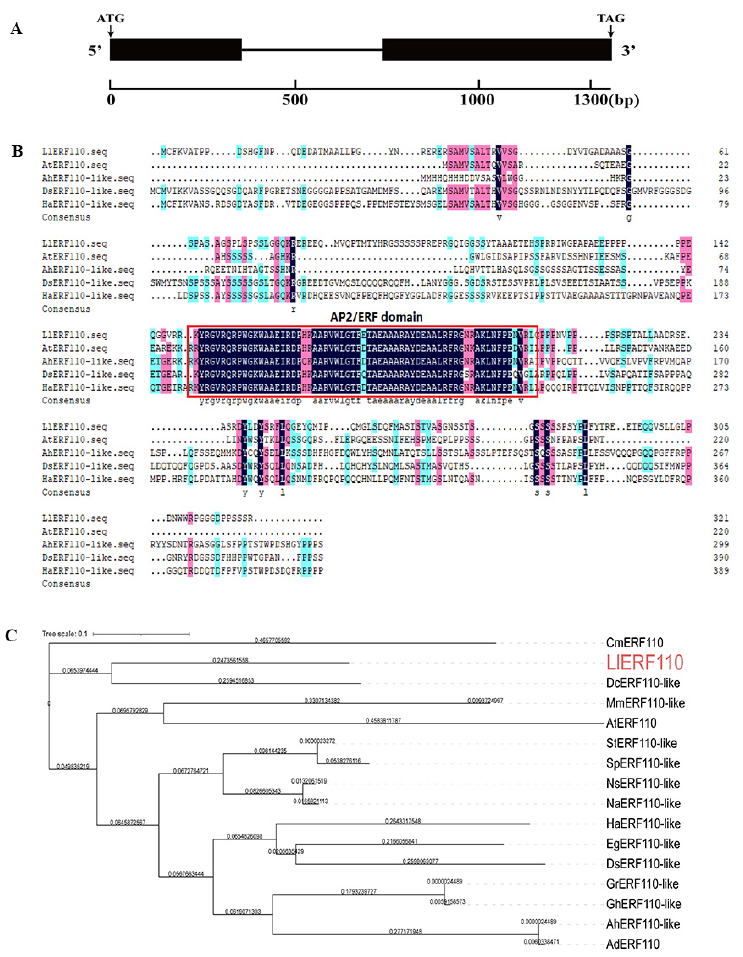
Figure 3. DNA structure and amino acid sequence of LlERF110 . ( A ) DNA structure of LlERF110 . ( B ) Sequence alignment of LlERF110 with ERF110 from Arabidopsis thaliana , Arachis hypogaea , Daucus carota var. sativa , and Helianthus annuus . AP2/ERF domain is indicated by red box, blue color means the conserved amino acid and red color means the difference among homologous protein from different species.( C ) Phylogenetic tree of LlERF110 and ERF110s in other species. The ERF110 pro- teins were from: Arachis duranensis AdERF110 (XP_015942600.1), Arachis hypogaea AhERF110 − like (XP_025621140.1),